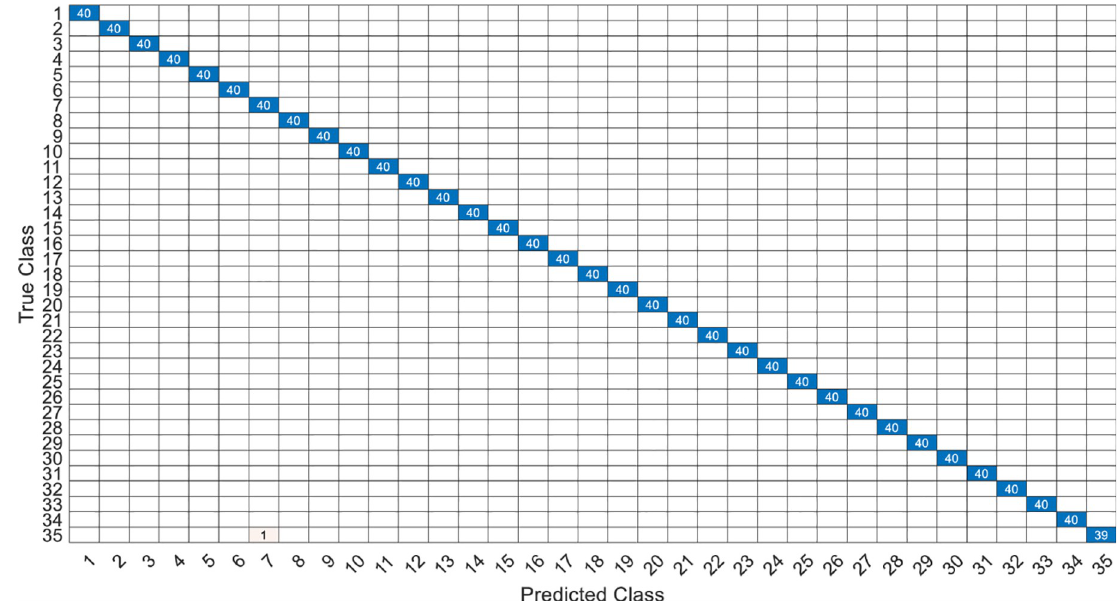
Fig 32. The confusion matrix of PCA-DNN-12-layer model with LPC datasets.